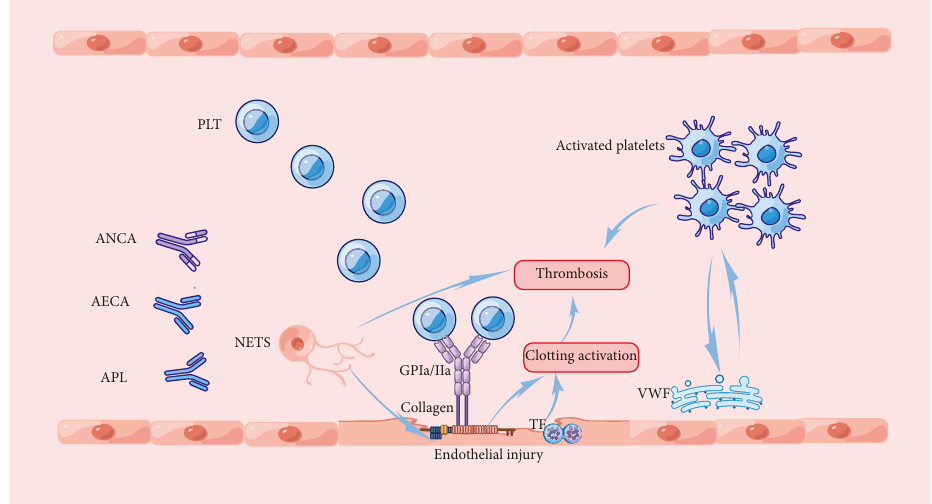
Figure 1: When endothelial cells are damaged by autoantibodies (ANCA,AECA,APL) and neutrophil extracellular traps, collagen and TF are exposed to the circulating blood, which the coagulation cascade is activated. Circulating platelets adhere directly to collagen via glycoprotein Ia/IIa surface receptors. This adhesion is further enhanced by the release of von Willebrand factor (vWF) from the damaged vascular endothelium and activated platelets. These interactions further activate platelets,which ultimately lead to increased platelet ag- gregation and